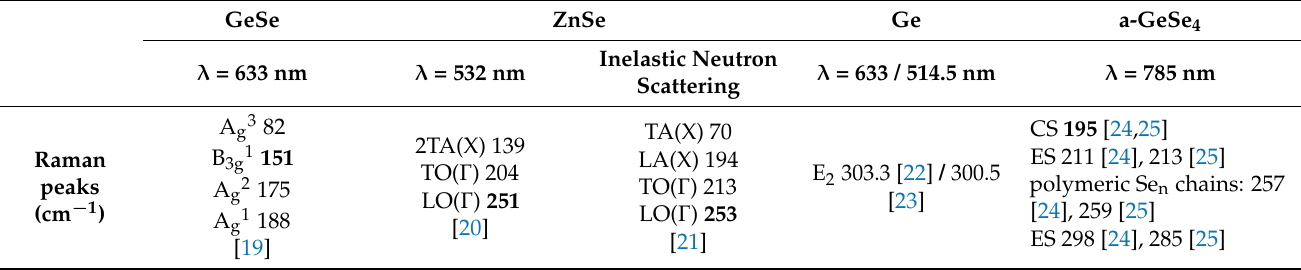
Table 6. The peaks positions in the Raman spectra for materials indicated in other studies. The bolded values are for the most intense peaks in each spectrum. TA, transverse acoustic mode; LA, longitudinal acoustic mode; TO, transverse optical phonon mode; LO, longitudinal optical phonon mode; LO( Γ ), LO at k = 0 ( Γ point); LA(X), LA at the point X (1, 0, 0); CS, corner-sharing GeSe